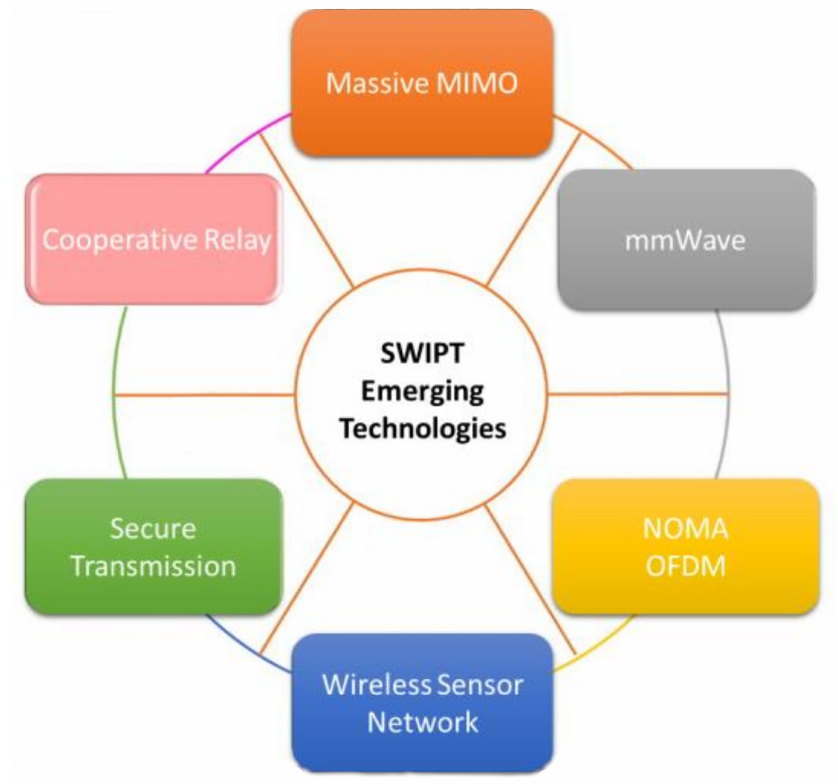
Figure 14. Emerging SWIPT